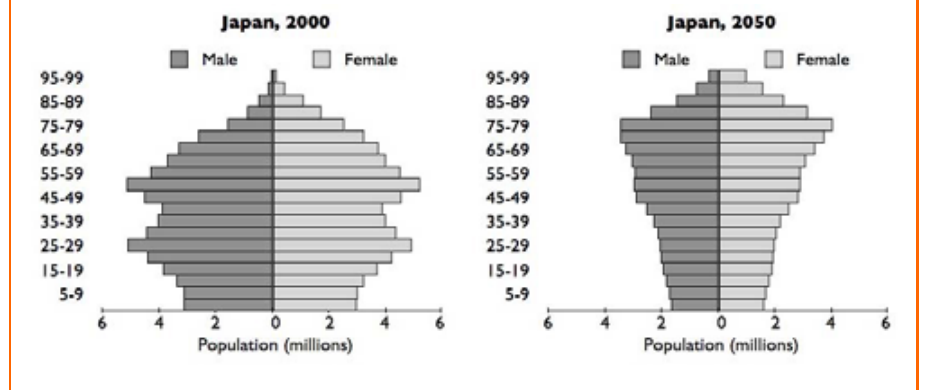
Figure 2: Population Pyramids for Japan (Data Source: